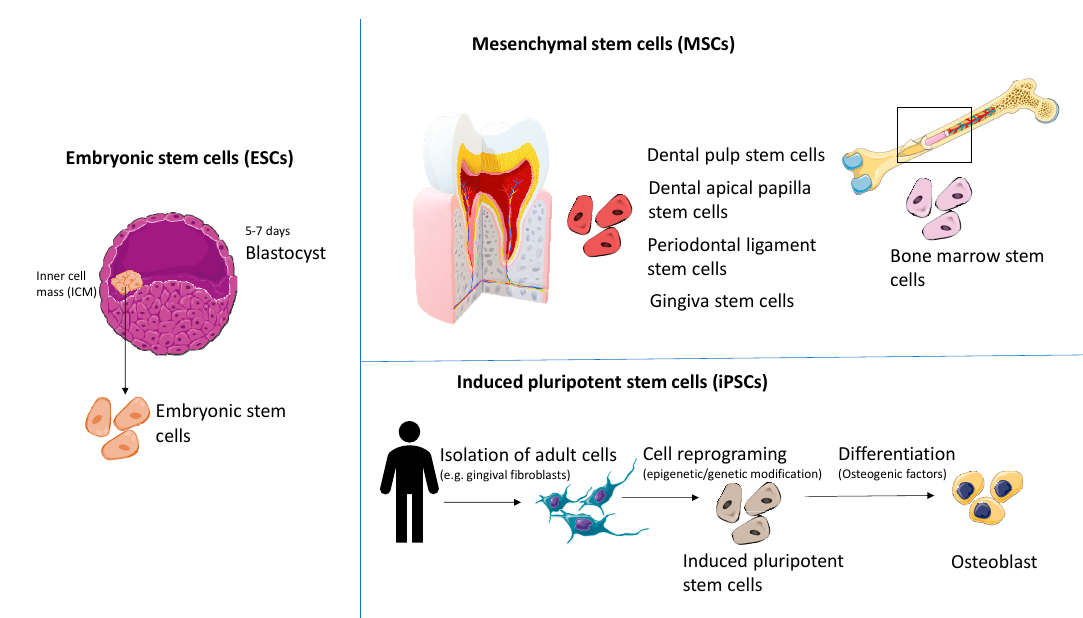
Figure 2. Types of stem cells used for regenerative medicine (focus on bone regeneration). Tissue regeneration is mainly based on three segments of stem cells: embryonic stem cells (ESCs), mesenchymal stem cells (MSCs) and induced pluripotent stem cells (iPSCs). ESCs are isolated from the 5–7 days blastocysts from the inner cell mass and MSCs are harvested from different dental tissues: dental pulp, dental follicle, dental apical papilla, periodontal ligament and gingival or bone marrow. In case of iPSCs, the method implies isolation of adult cells (e.g., gingival fibroblasts) which are subjected to reprogramming mechanisms using epigenetic or genetic modifiers. After the reprogramming strategy, the cells acquire stemness features which allows their further differentiation toward specific cellular entities (osteoblasts) due to the effects of a conditioned media.